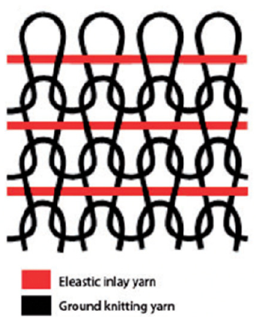
Figure 1. Fabric structure [11].